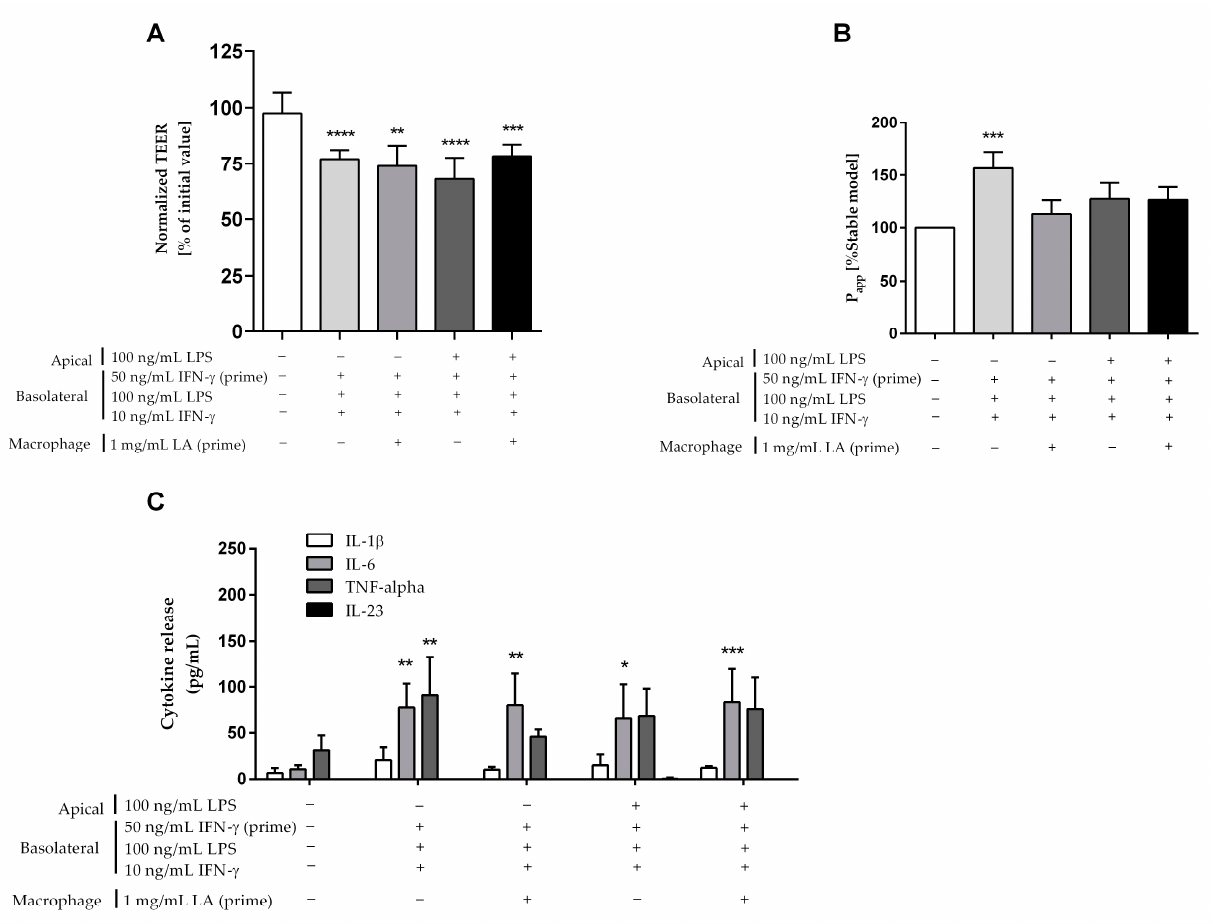
Figure 6. Comparison of different modifications on the “leaky gut” model using macrophage- like THP-1 cells (“ − “: non-treatment, “+”: treatment). Intestinal barrier function was assessed by ( A ) TEER and ( B ) permeability value (P app ) as compared to the control model. ( C ) The secretion of key pro-inflammatory cytokines IL-1 β , IL-6, IL-23, and TNF- α was quantified in the basolateral compartment of the models after 24 h cultivation. Bars are mean ± SD ( n ≥ 3). * p < 0.05, ** p < 0.01, *** p < 0.001, **** p < 0.0001 as compared to the control